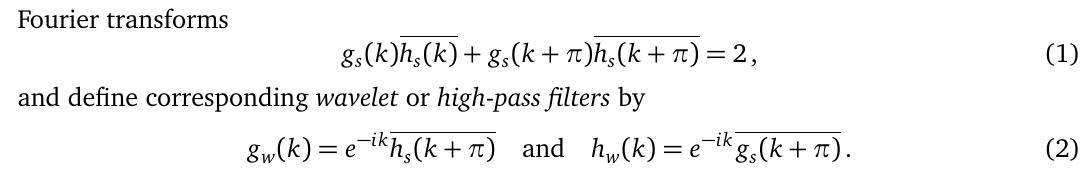
Figure 2: Iterating the wavelet decomposition W tration for the Haar wavelet filters [ 19 ]